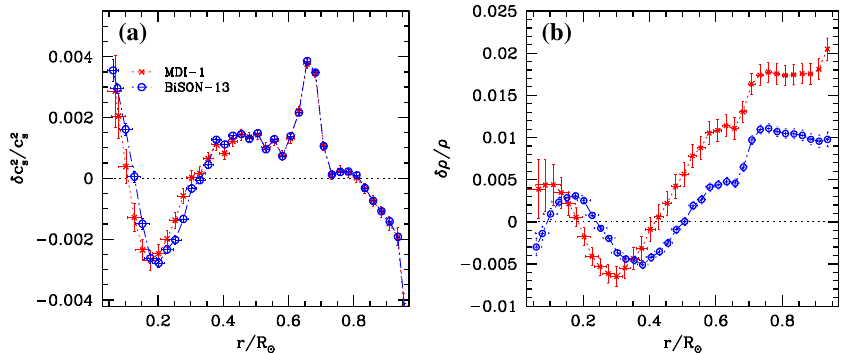
Fig. 24 The relative sound-speed and density differences between the Sun and Model S obtained by inverting two different data sets that only differ in their (cid:2) = 0, 1, 2, and 3 modes. The results are from Basu et al. (2009) and the two mode sets, labelled MDI-1 and BiSON-13 are described in that paper. Note that while there is very little change in the sound-speed differences, the density differences change significantly